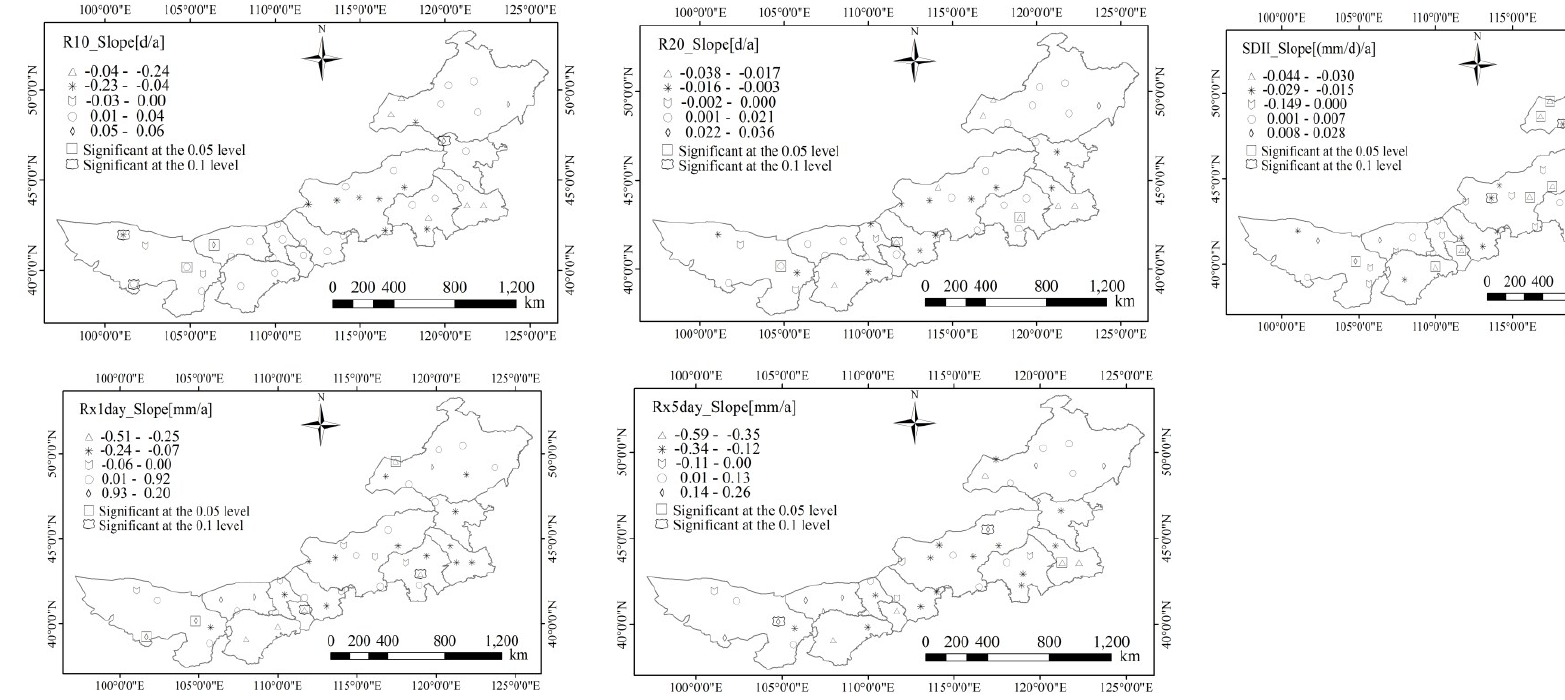
Figure 3. Spatial variation of extreme precipitation indices in the IMP during 1959–2014.